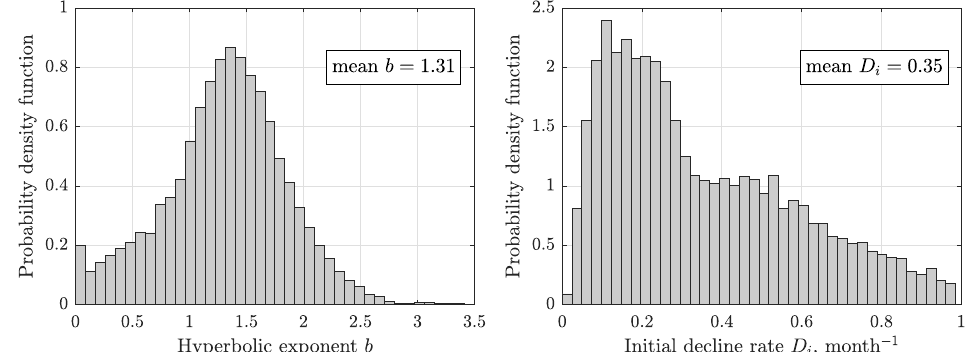
Figure 3. Probability distribution functions for the parameters of the hyperbolic DCA matches of 11,312 non-refractured wells in the Barnett plotted in Figure 2a. For each well, we apply the algorithm from the Reservoir Engineering Handbook (4th edition) [13] to solve for the Arp’s decline-curve exponent, b , and the initial decline rate, D i . The mean values of b and D i are 1.31 and 0.35 month − 1 , respectively. In comparison, a recent published DCA analysis for 10,237 Barnett wells [14] gives the average values of b and D i as 1.477 and 0.1362 month − 1 , respectively. Even though the original formulation of hyperbolic DCA by Arps [15] requires b ∈ [ 0,1 ] , for many hydrofractured gas wells, b > 1, and sometimes b is as high as 3.5 [16]. Therefore, we did not constrain the b exponents in Figure 2. Constraining them